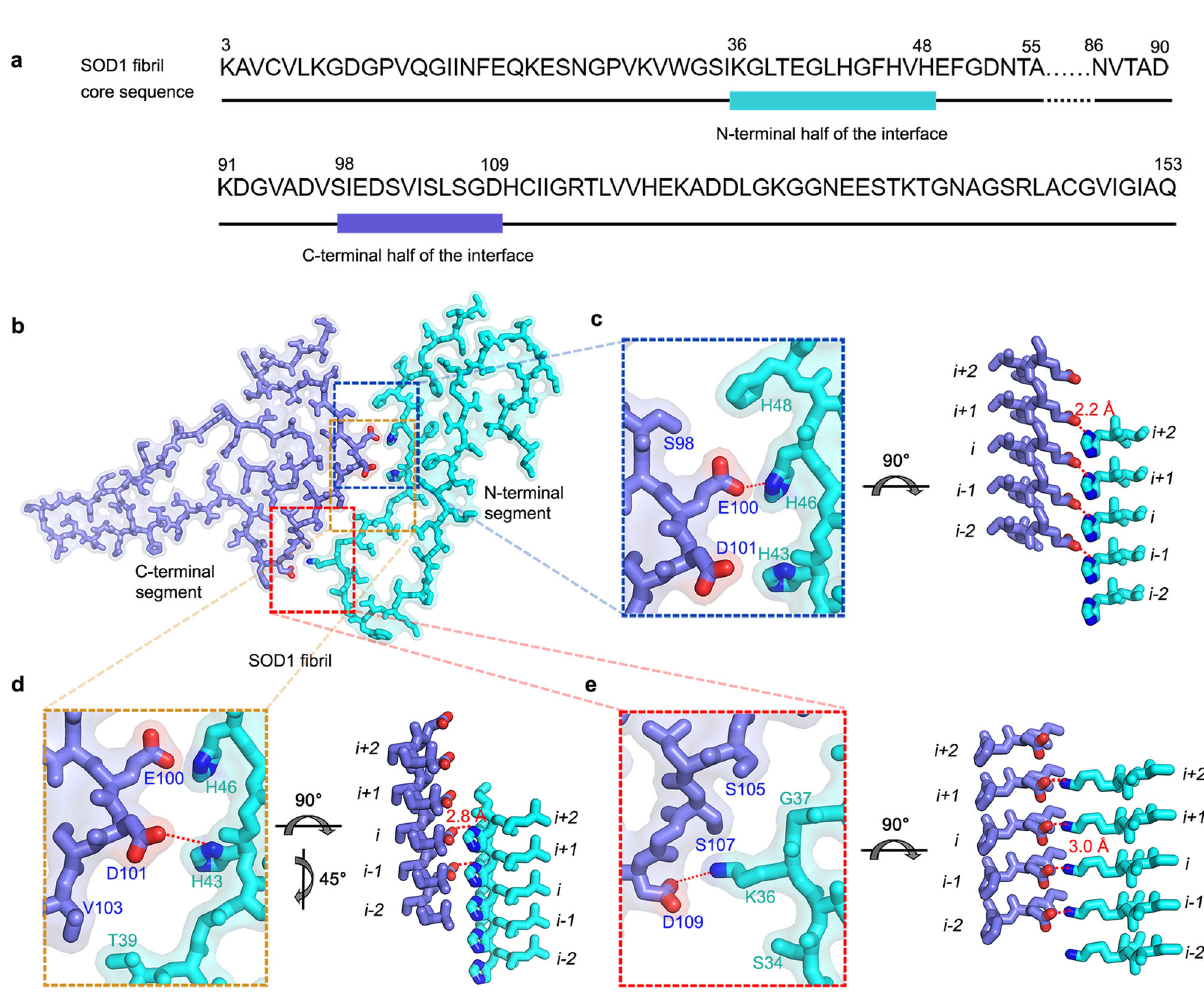
Fig. 3 Close-up view of the intramolecular interface between the N- and C-terminal regions of SOD1 fi bril. a The primary sequence of the SOD1 fi bril core. The cyan bar marks the N-terminal half of the interface and the blue bar marks the C-terminal half. The dotted lines correspond to residues 56 to 85 not modeled in the cryo-EM density and represent an internal disordered segment between the N- and C-terminal regions of SOD1 fi bril. b A space- fi lled model overlaid onto stick representation of the SOD1 fi bril, in which the N-terminal segment is shown in cyan and the C-terminal segment in blue. Lys/Asp pairs, His/Asp pairs, and His/Glu pairs that form salt bridges are highlighted in red (oxygen atoms in Asp and Glu) and blue (nitrogen atom in Lys and His), and the intramolecular interface is magni fi ed in c to e . c – e Magni fi ed top views of the three regions of the intramolecular L-shaped interface between the N- and C-terminal regions of SOD1 fi bril, where three pairs of amino acids (Lys36 and Asp109; His43 and Asp101; and His46 and Glu100) form three salt bridges. Two side views (right) highlighting a strong salt bridge between Glu100 from the C-terminal segment ( i ) and His46 from the adjacent N-terminal segment ( i + 1 ), with a distance of 2.2 Å (red), or between Asp101 from the molecular layer ( i – 1 ) of the C-terminal region and His43 from the molecular layer ( i + 2 ) of the N-terminal region, with a distance of 2.8 Å (red). A side view (right) highlighting a strong salt bridge between Asp109 from the C-terminal part ( i ) and Lys36 from the adjacent N-terminal part ( i + 1 ), with a distance of 3.0 Å